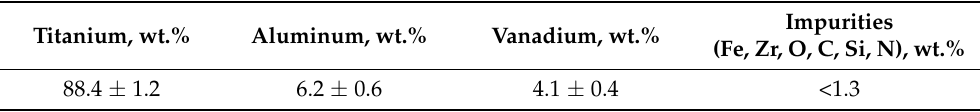
Table 1. Elemental composition of Ti-6Al-4V alloy before immersion in 0.9% NaCl solution, X ± SD. Titanium,